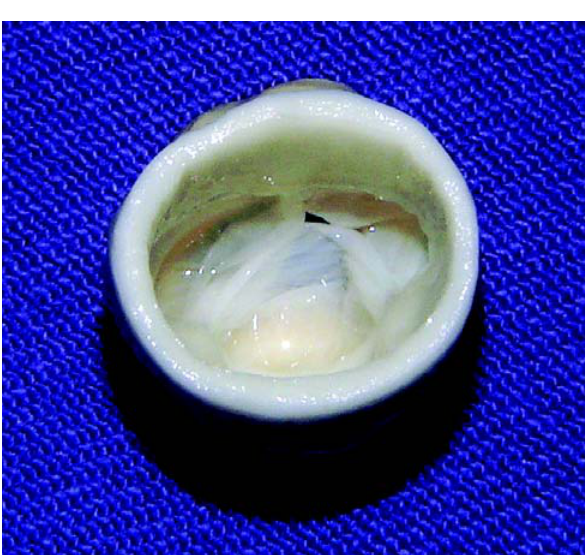
Fig. 1 – Aspecto da valva do xenoenxerto porcino com tratamento L-Hydro previamente ao implante